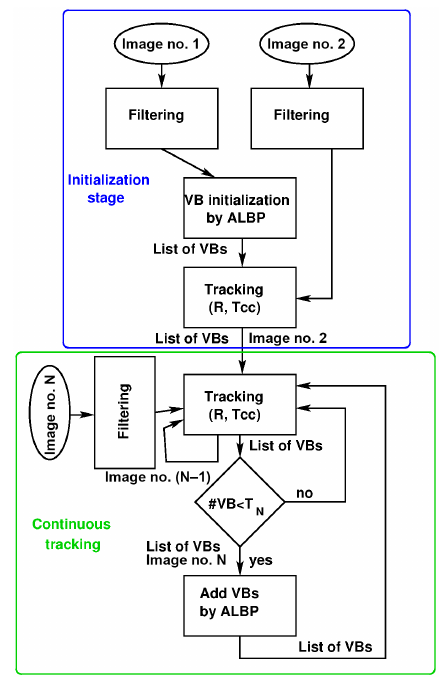
Figure 2. Flow diagram of the continuous VB